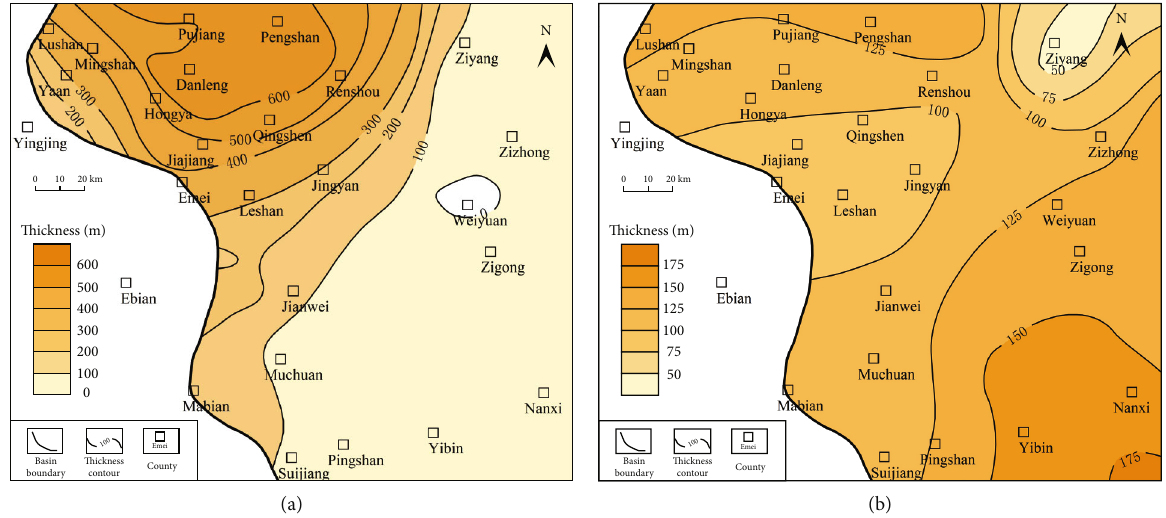
Figure 8: Planar distribution characteristics of the cumulative thickness values of the major caprocks in the Sichuan Basin. (a) Middle and Lower Triassic. (b) Lower